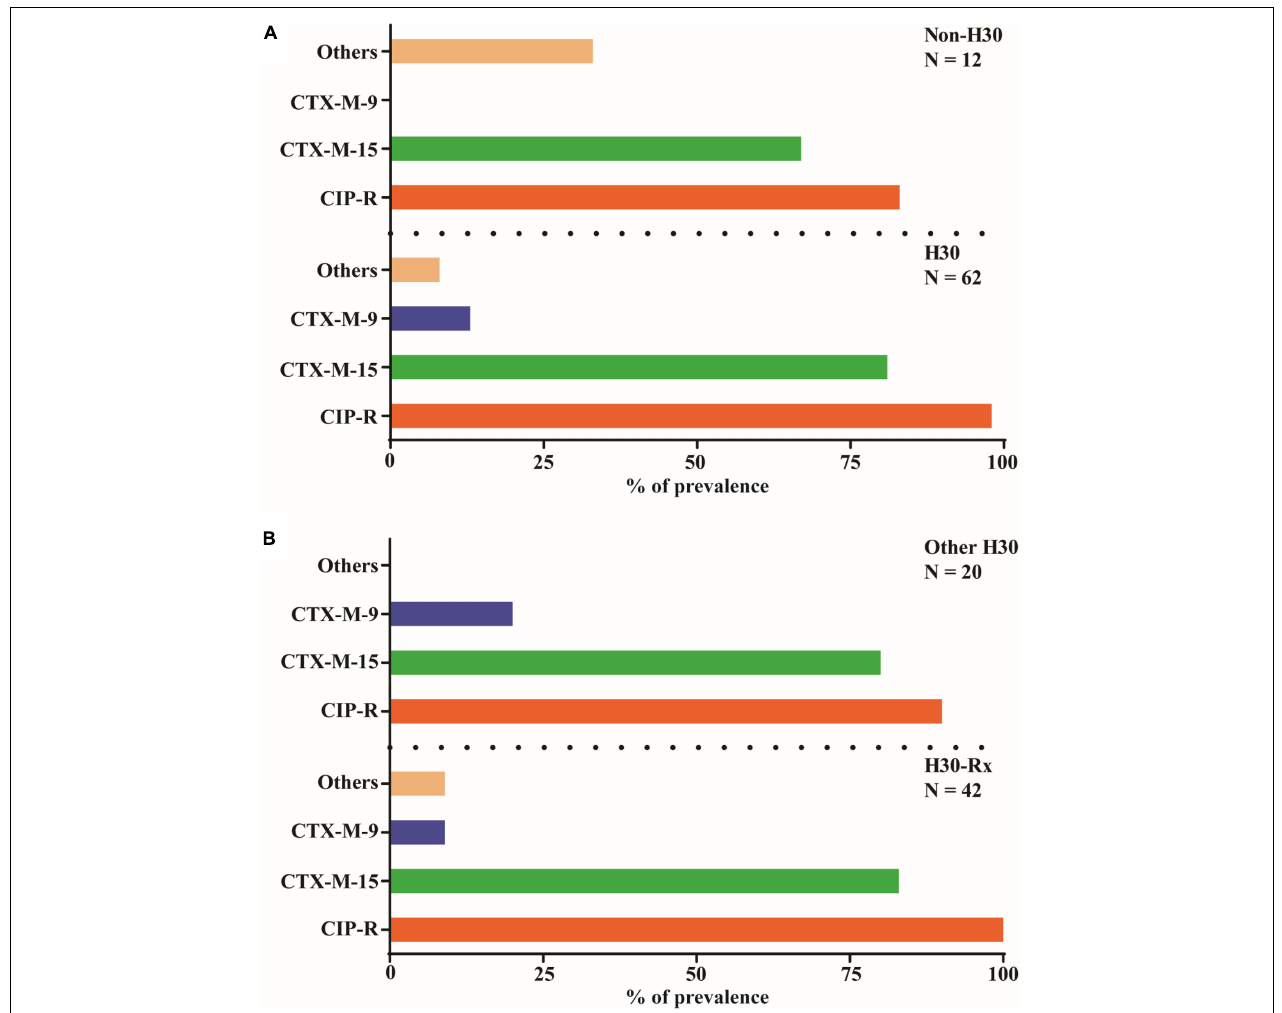
FIGURE 3 | Prevalence of key CTX-M genetic variants and ciprofloxacin resistance among 74 ST131 isolates. Note that as with all strains in this study the ST131 isolates were confirmed producers of β -lactamases as measured by resistance ampicillin (see Figure 2A ). (A) All 74 ST131 isolates classified into H30 subclone ( n = 62) and non-H30 subclone ( n = 12). These 74 isolates were then tested for the prevalence of CTX-M gene distribution following PCR amplification and sequencing. Most of the isolates harboured either the gene encoding for the β -lactamase enzyme CTX-M-15 or CTX-M-9. A Pearson Chi-square test was used to evaluate if this distribution is statistically significant. The CTX-Ms distribution profile among the isolates of the two different groups were not significantly different ( P > 0.05). (B) Of the 62 H30 isolates, 67.7% ( n = 42) were identified as H30Rx using PCR. The vast majority of all isolates were ciprofloxacin resistant (CIP-R), CTX-Ms in group 1 other than CTX-M-9 or CTX-M-15 are classified collectively as